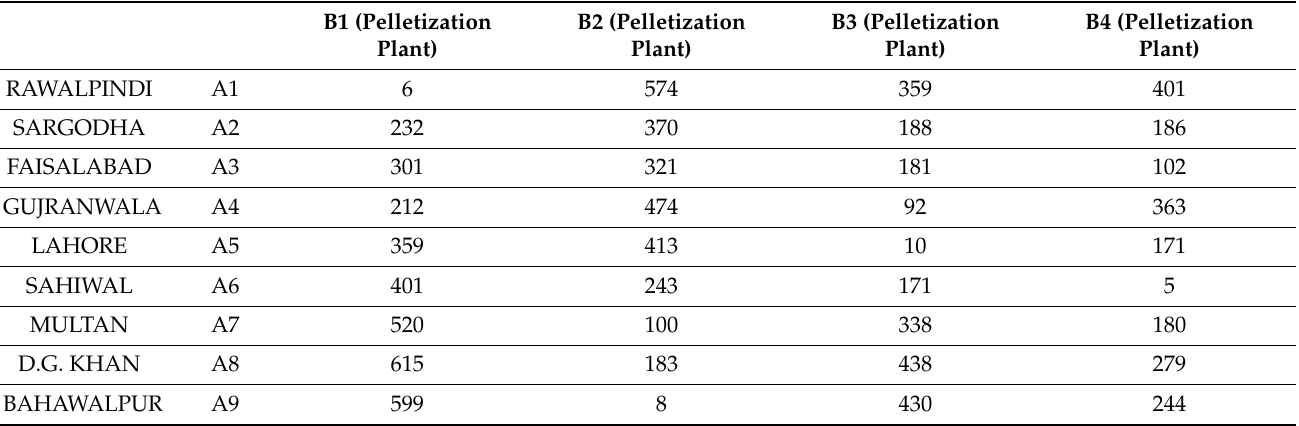
Table A5. Transportation cost of biomass between biomass supply terminal and pelletization plants (USD/ton-km).